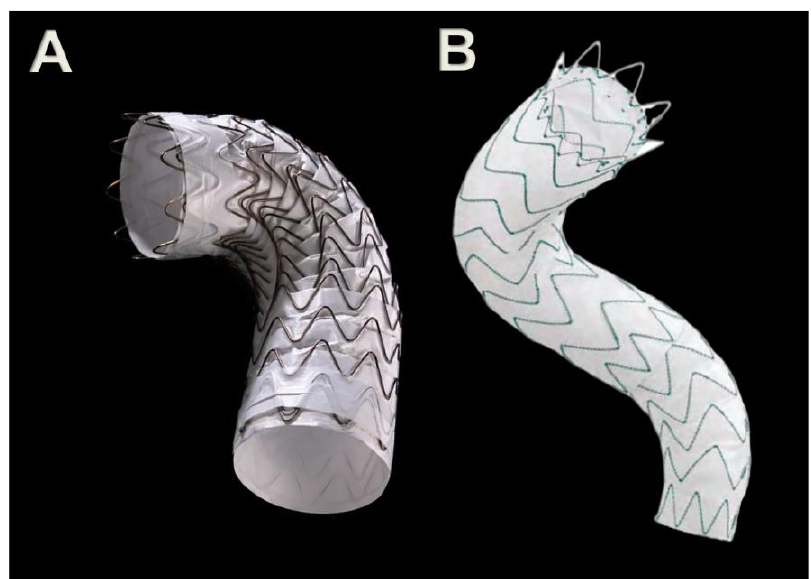
Figure 4. The Conformable GORE TAG ® (C-TAG) thoracic stent graft (W. L. Gore & Associates, Flagstaff, AZ, USA) on the left side ( A ), and the Medtronic Valiant Captivia™ (Medtronic Inc., Santa Rosa, CA, USA) on the right side ( B ). Table 1. Description of the most important features of the Gore C-TAG ® and the Medtronic Valiant Captivia™, according to Instruction for Use.